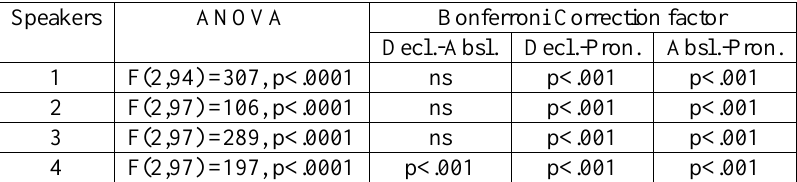
Table 1. Statistical comparisons between the initial tonal values of the three utterance types, ANOVA and the Bonferroni correction factor. Hereafter a result of “no significant difference” (p>.05), is indicated by the label ns. Sentence types (declarative, absolute interrogative, and pronominal interrogative) were independent factors and initial tonal value was the dependent